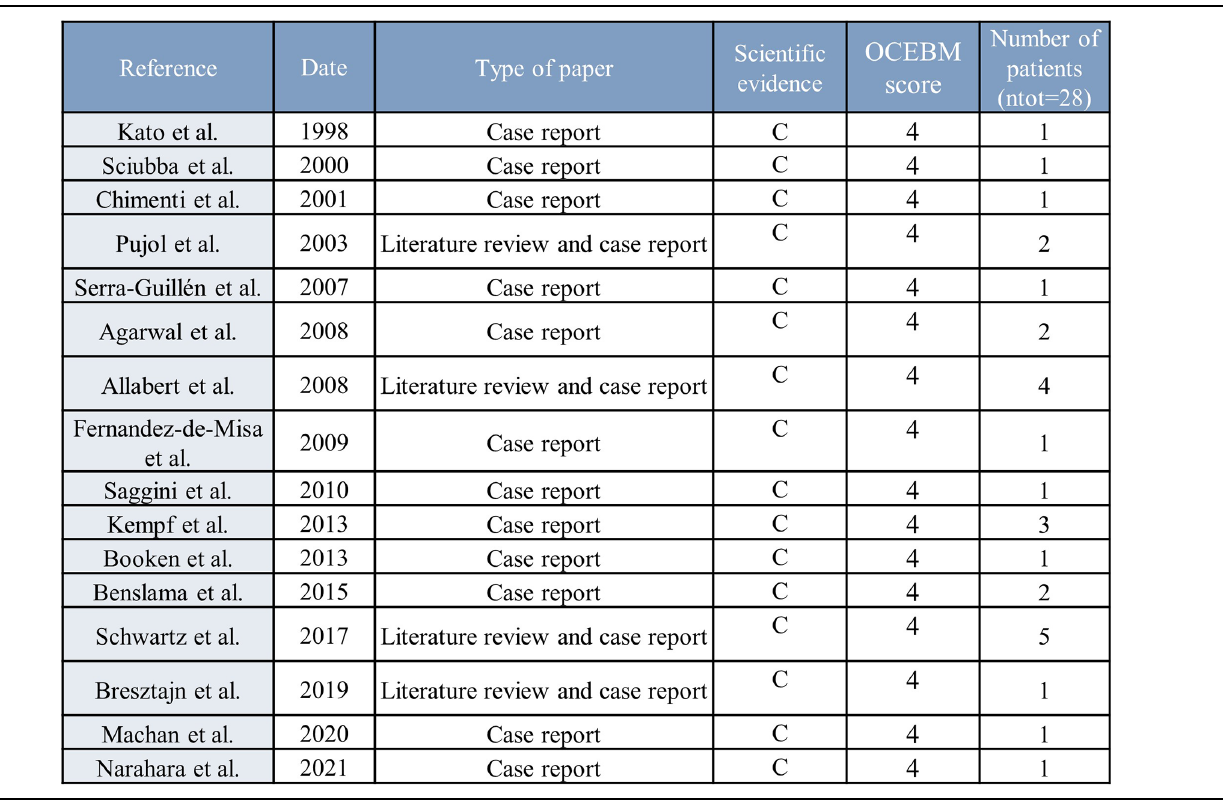
Table II. Included studies. Scienti fi c evidence: scoring from the National Agency for Accreditation and Assessment in Health (ANAES); OCEBM : Oxford Centre for Evidence Based Medicine